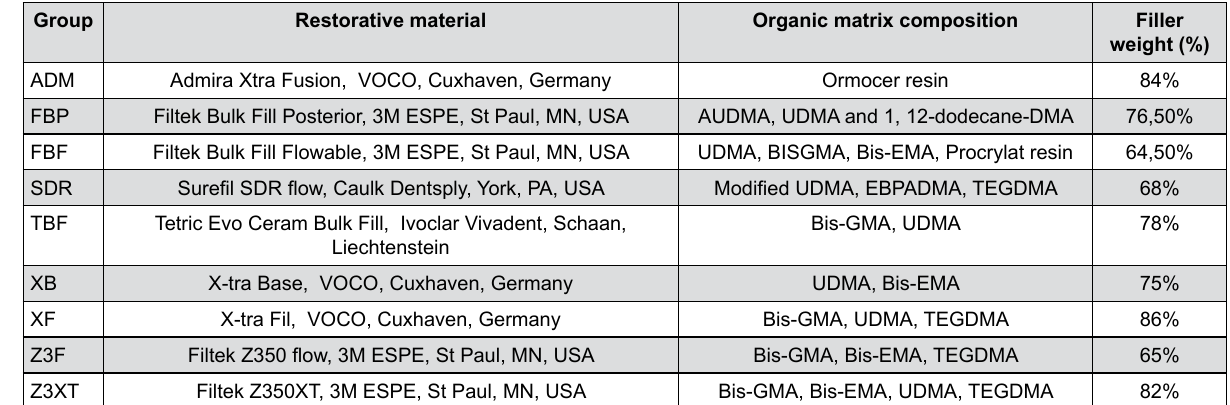
Figure 1- Different groups with respective composition and manufacturer